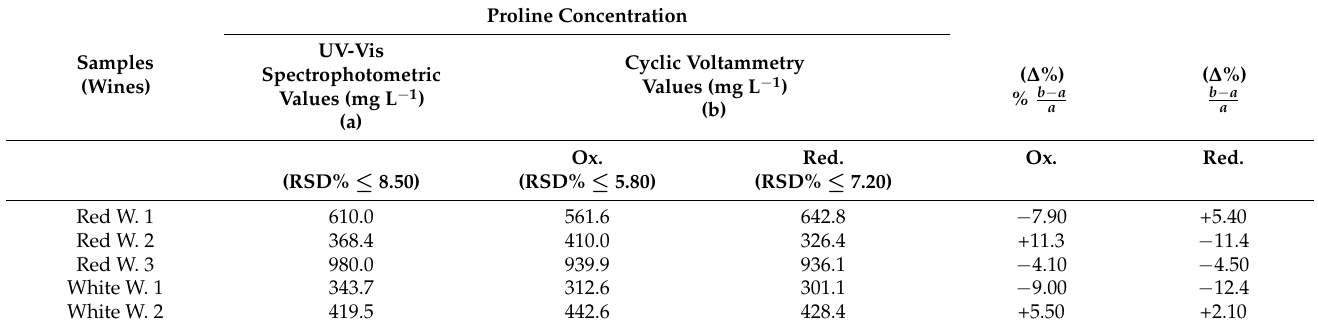
Table 4. Experimental values of proline concentration found in five different wine samples using the catalytic voltammetric sensor developed in this work, and comparison with the same data obtained using the ninhydrin spectrophotometric method. All values of proline concentrations are the real found values of not diluted wine samples. The percentage differences ∆ % between the values of proline concentration obtained by the CV method and by the spectrophotometric method are also reported.